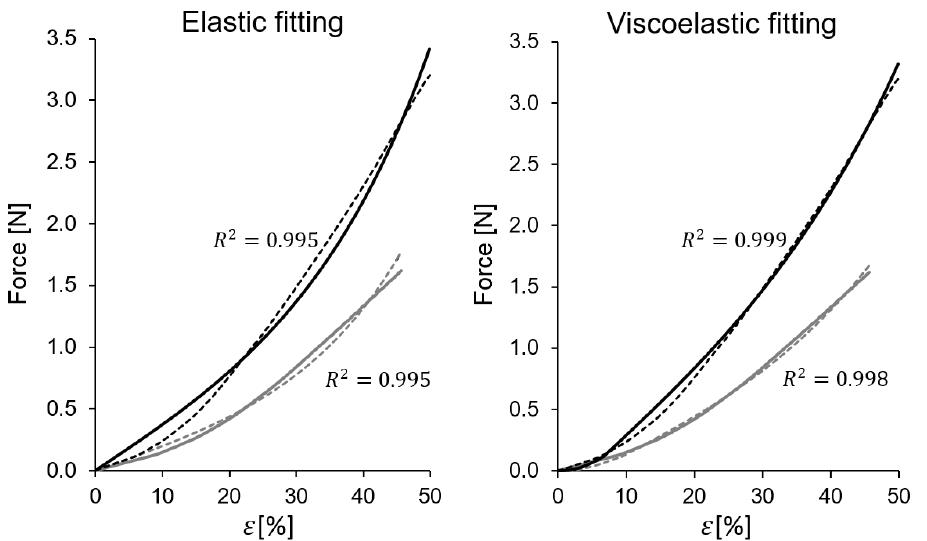
Figure 5. Two typical examples of force-strain curves, compared with the fitting of the elastic model and the fitting to the viscoelastic model (specimens 2628B (gray) and 2634C